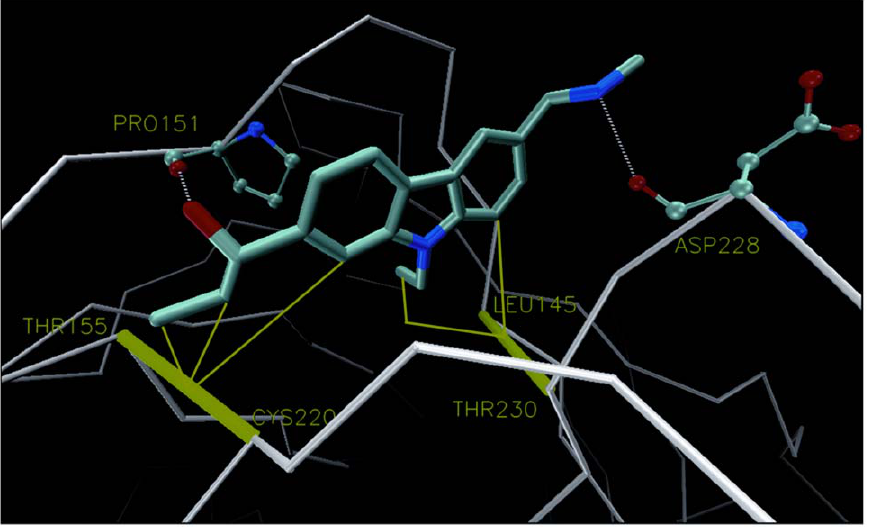
Figure 11. Illustration of the wrapping interactions between T-p53C-Y220C and the second modification of PhiKan083 (molecule B in Fig.7).